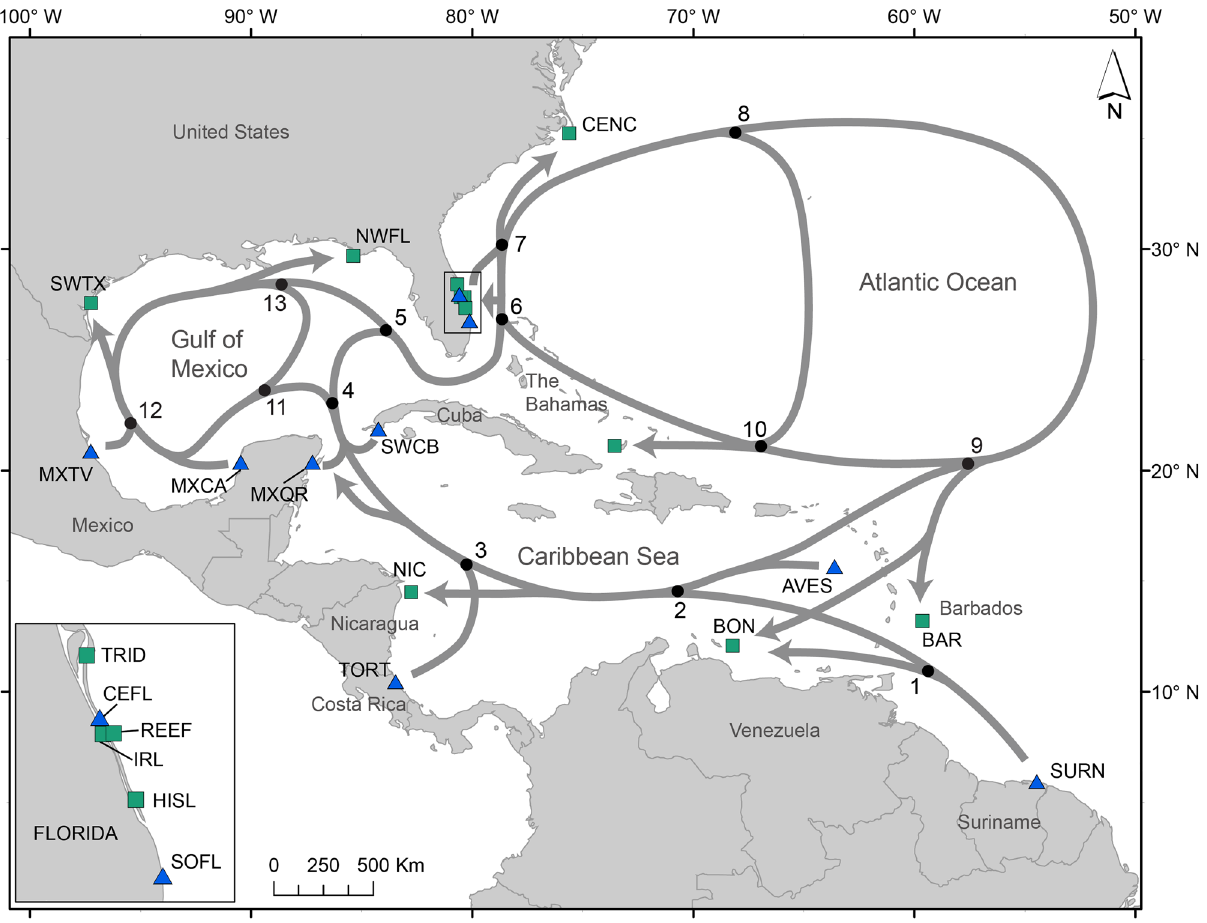
Figure 1. Probable routes used by juvenile green turtles to estimate the relative distances between rookeries and foraging areas; general current direction indicated by gray arrows. Blue triangles are rookeries, and green squares are mixed stock aggregation areas. Samples from MB are part of the CEFL rookery. Rookeries: AVES Aves Island, Venezuela, SURN Matapica and Galibi, Suriname, TORT Tortuguero, Costa Rica, MXQR Quintana Roo, Mexico, MXCA Campeche and Yucatán, Mexico, MXTV Tamaulipas and Veracruz, Mexico, SWCB Guanahacabibes Peninsula, Cuba, SOFL South Florida, United States, CEFL Central Florida, United States. Mixed stocks: BAR multiple areas, Barbados, BON Lac Bay, Bonaire, NIC Northeast Nicaragua, Nicaragua, BAH Southern Bahamas, The Bahamas, SWTX Southwest Texas, United States, NWFL Northwest Florida, United States, HISL Hutchinson Island, United States, RSBI Reef at Sebastian Inlet, United States, IRL Indian River Lagoon, United States, TRID Trident Basin, United States, CENC Central North Carolina,